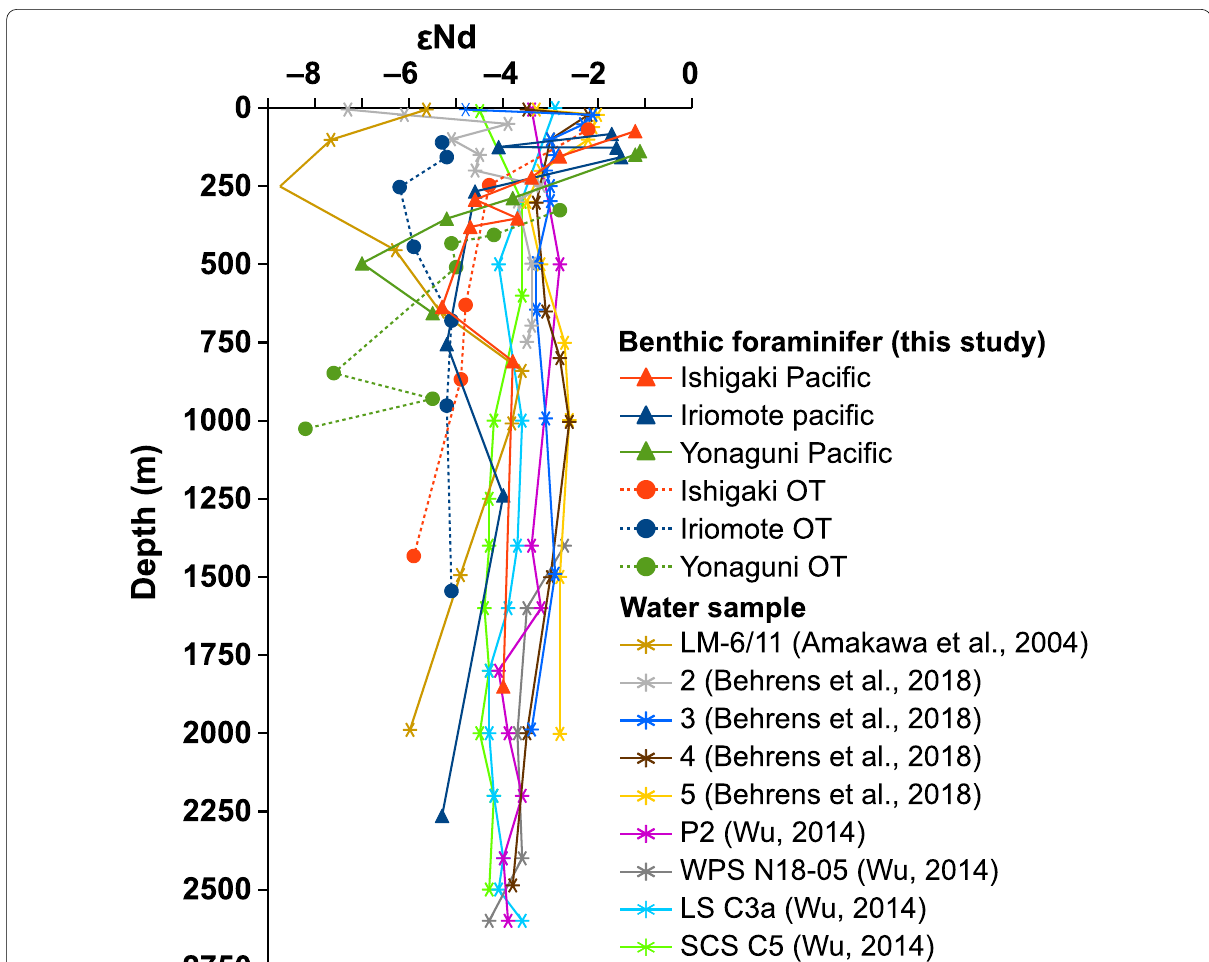
Fig. 5 εNd profiles for the study area, together with those reported for the northwestern Pacific (Amakawa et al. 2004b; Wu, 2014; Behrens et al.